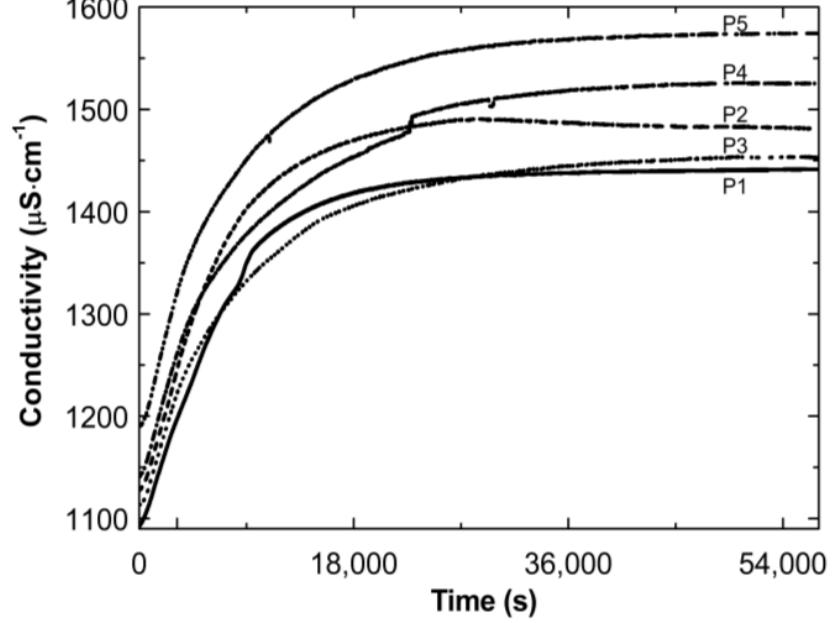
Figure 4. Conductivity changes as a function of time in the post-reaction mixtures of P1–P5 during cooling procedure.